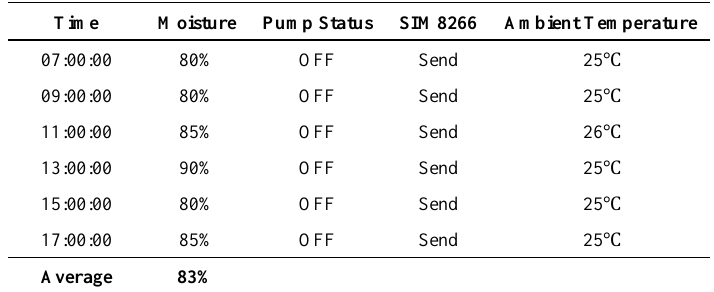
Table 3. Testing of soil moisture control in rainy weather.